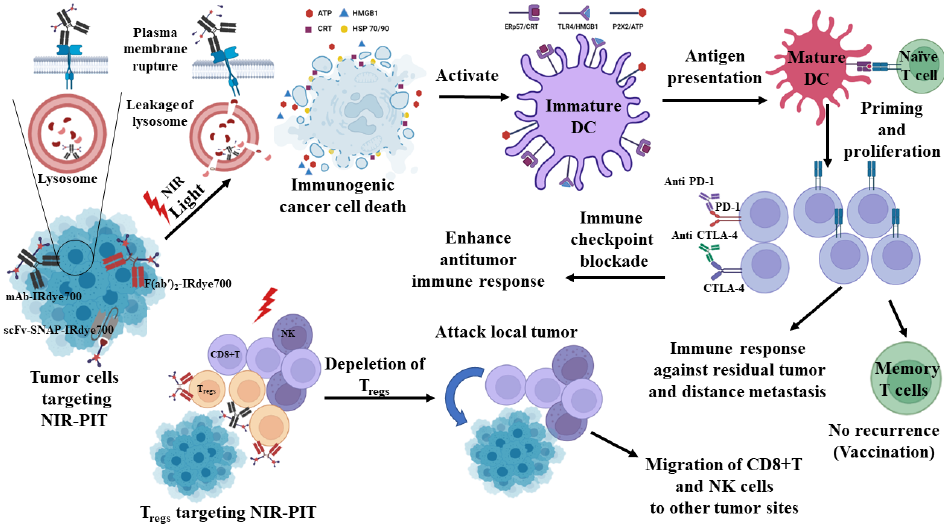
Figure 1. Mechanism of the NIR-PIT approach and its immunological consequences.